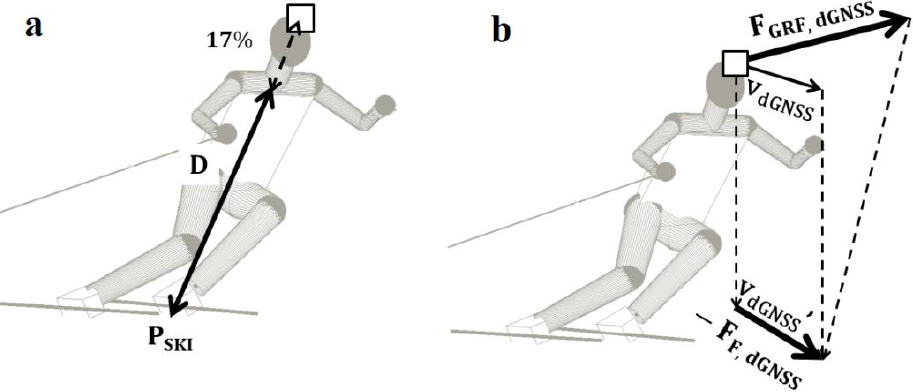
); SKI ) calculation. The direction of F is defined by F F ) onto the snow surface ( v ’). F is dGNSS dGNSS F ) onto v GRF,dGNSS dGNSS